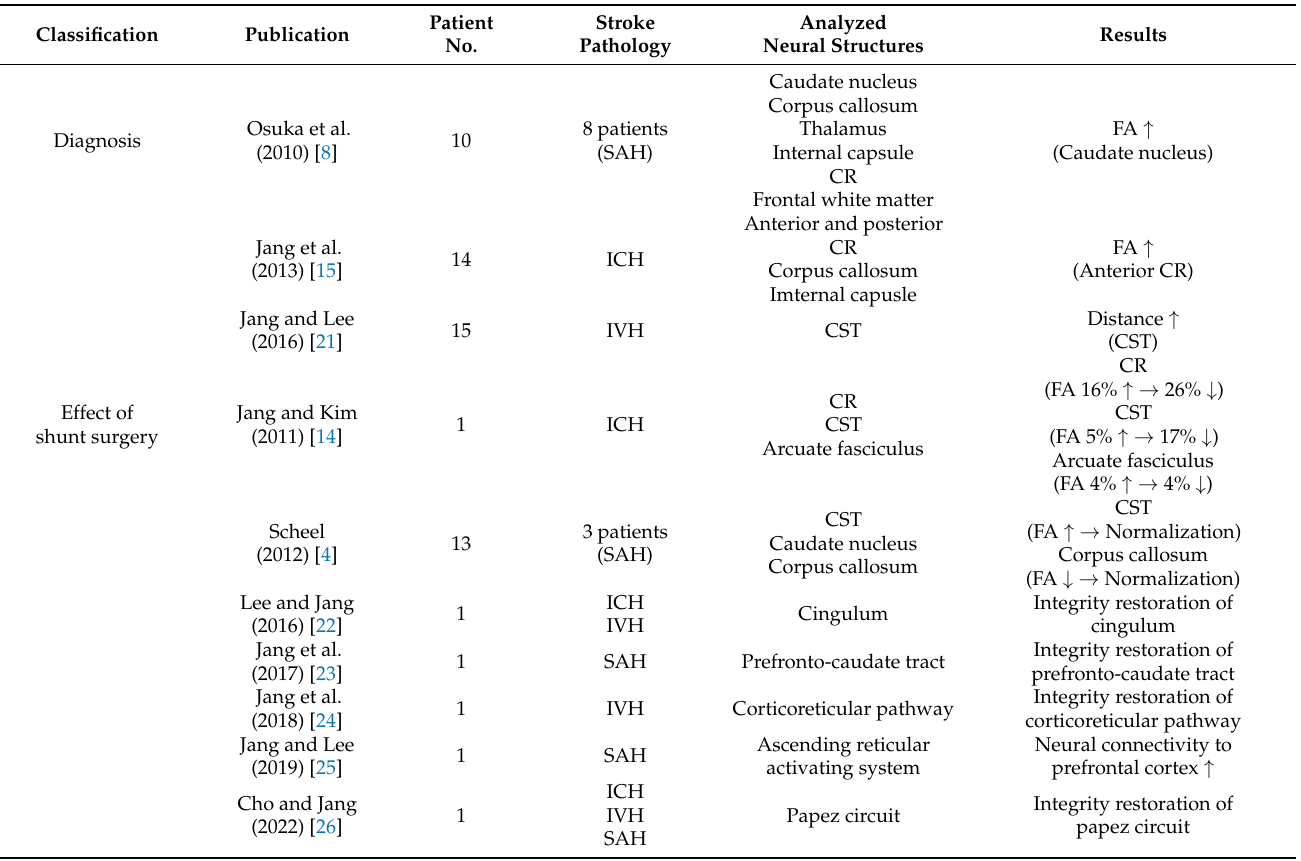
Table 1. Diffusion tensor imaging studies related to diagnosis and estimation of shunt effect for hydrocephalus in stroke